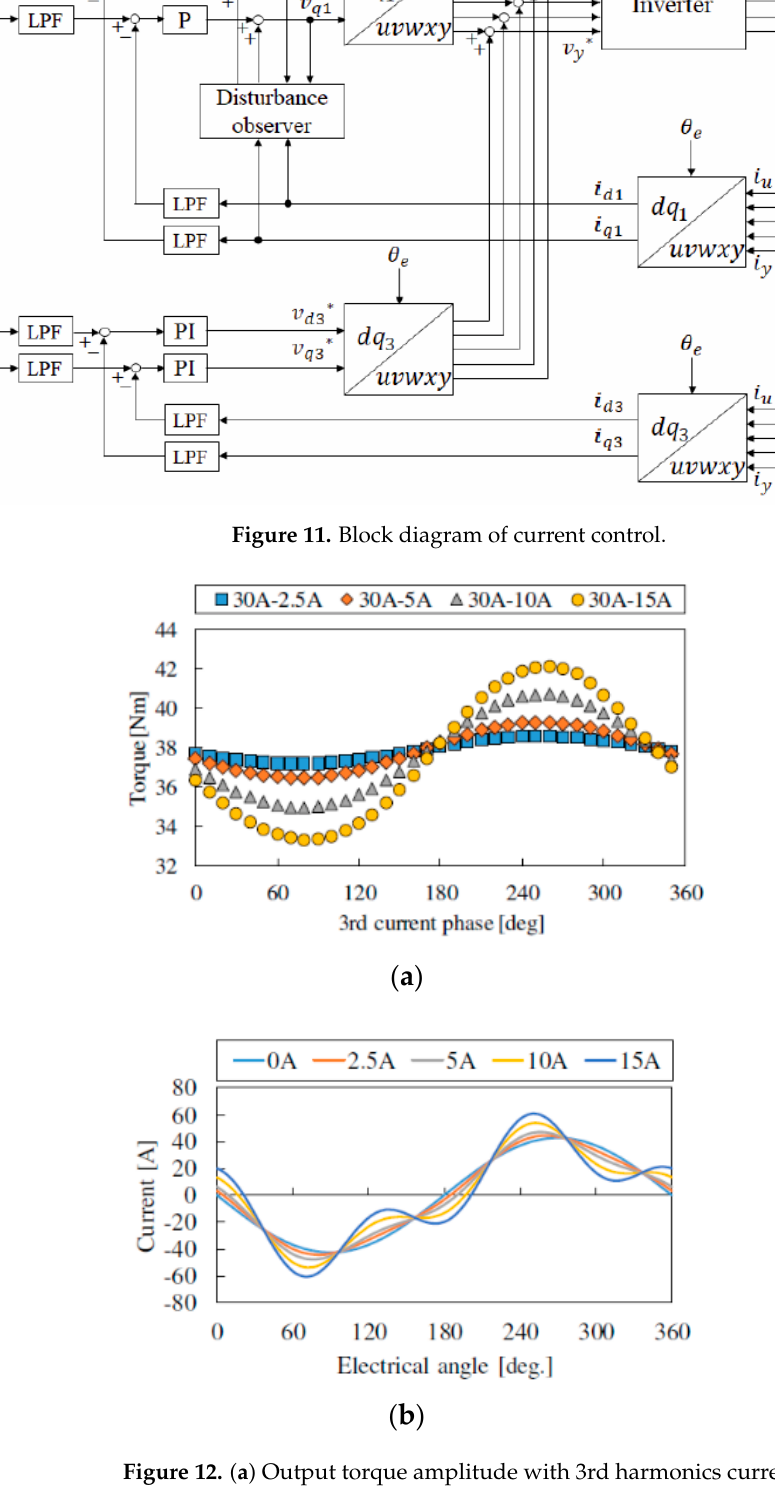
2.5 A–15 A harmonics are added. ( b ) Current waveforms when 3rd harmonics is added to the fun-